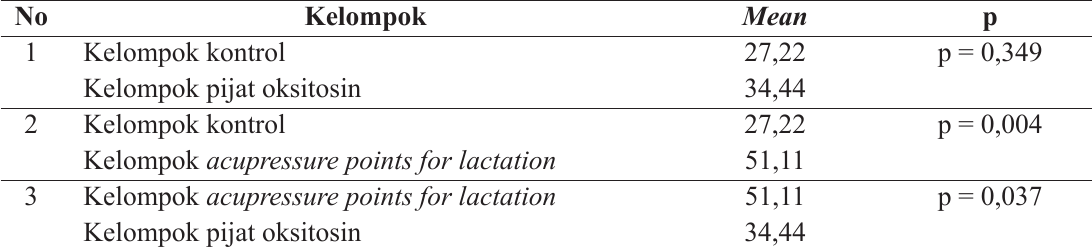
Tabel 5. Perbedaan peningkatan produksi ASI dengan Uji